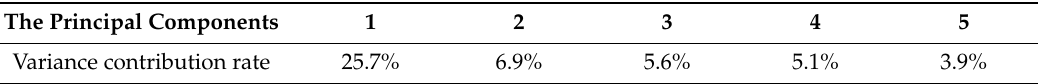
Table 3. Variance contribution ratio of the first five principal